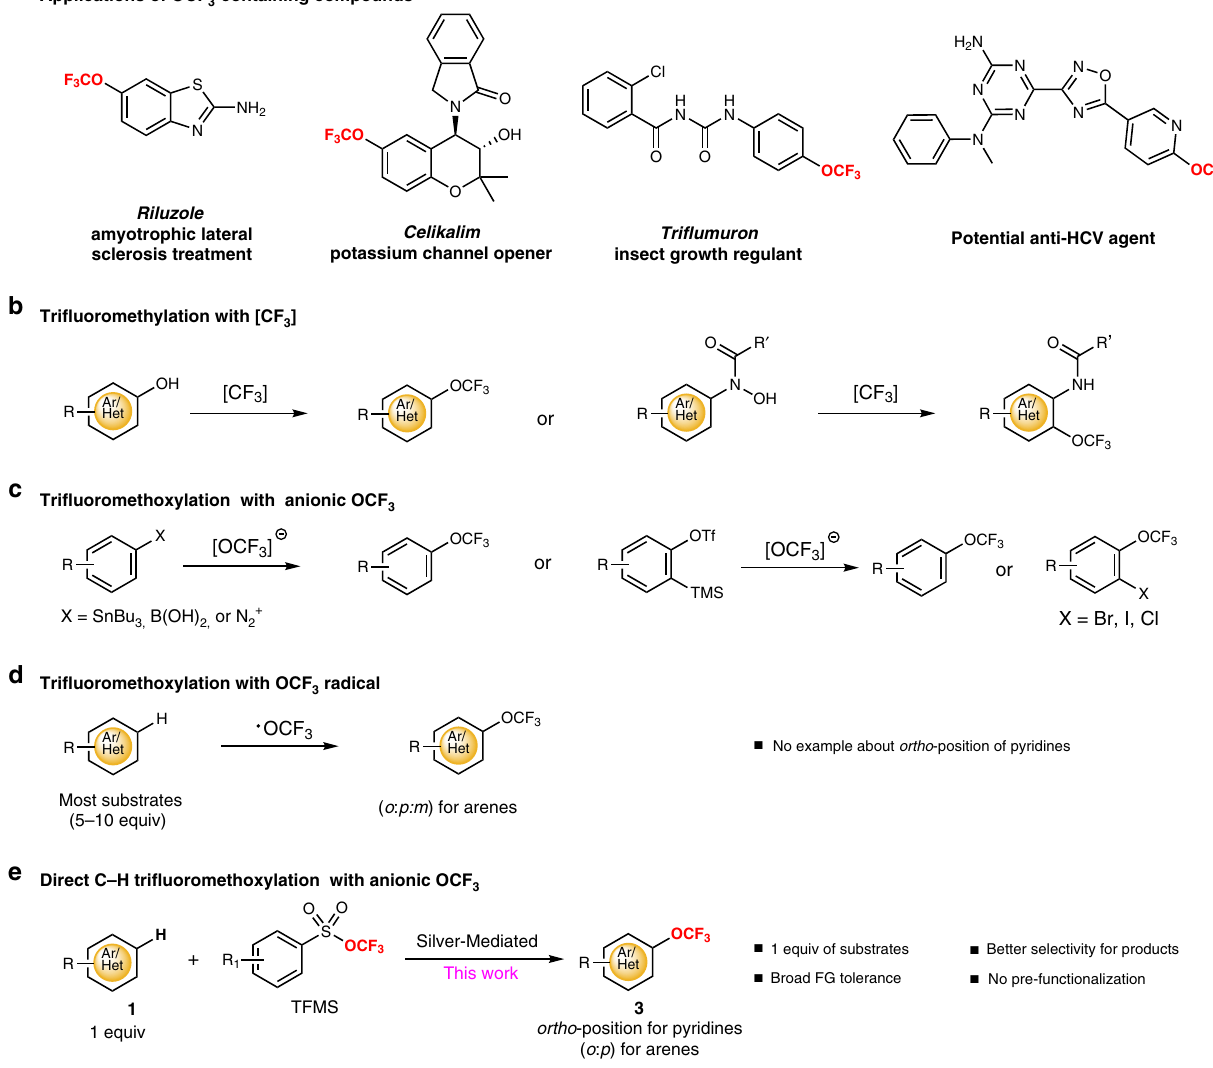
Fig. 1 Arene and heteroarene C-H tri fl uoromethoxylation. a Applications of OCF 3 -containing compounds. b Tri fl uoromethylation with [CF 3 ]. c Tri fl uoromethoxylation with anionic OCF 3 . d Tri fl uoromethoxylation with OCF 3 radical. e Direct C-H tri fl uoromethoxylation with anionic OCF 3